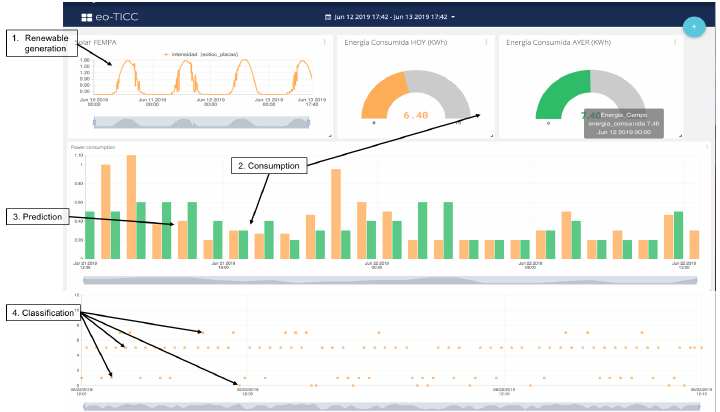
Figure 22. Dashboard results on the cloud platform: data captured by the generation (orange line in 1), consumption (green bar in 2), prediction (orange bar in 3), and classification (orange point in 4) algorithms implemented on edge